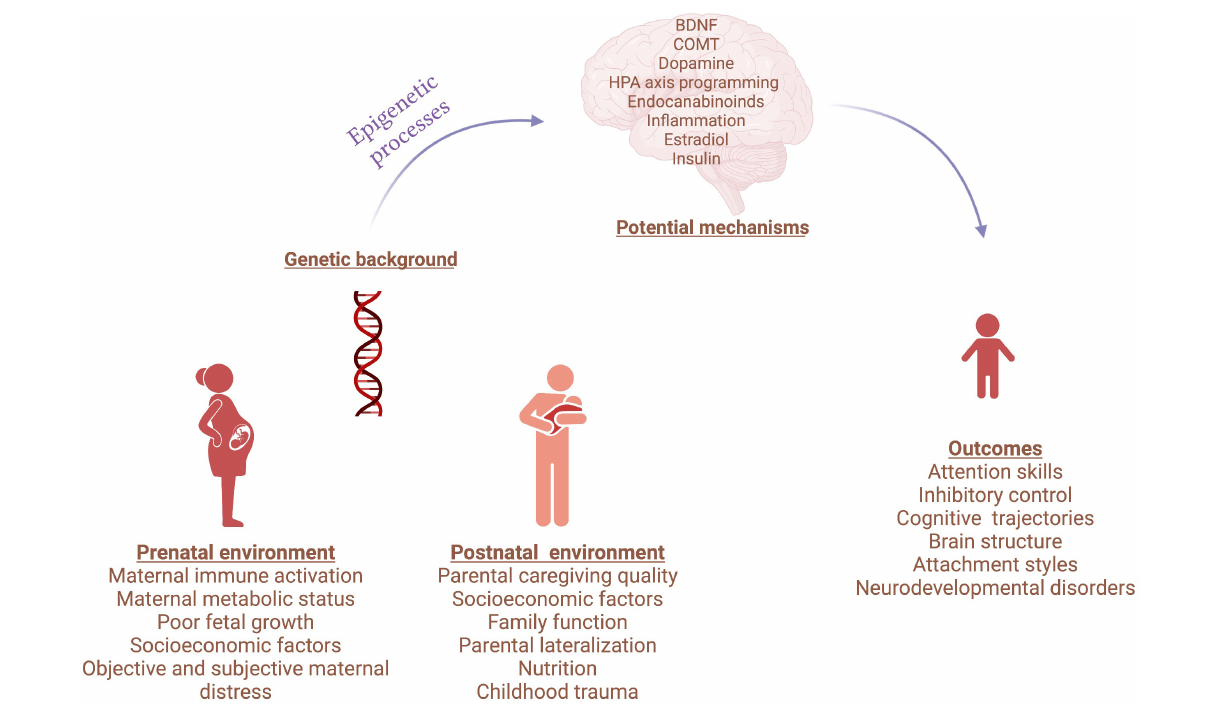
FIGURE 1 | Gene and environment interactions in neurodevelopmental disorders. Created with